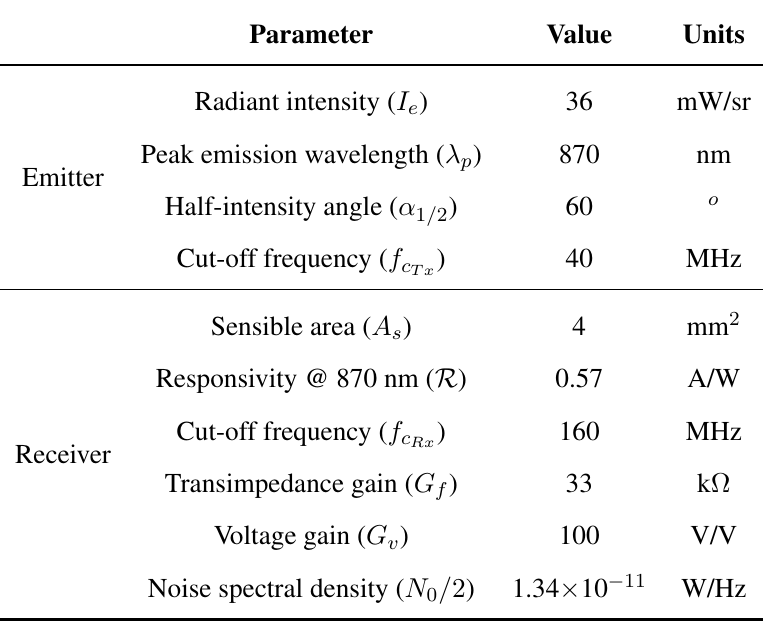
BPX-65R) and conditioning stage parameters to implement an IR link for 25 MHz chip-rate. Parameter